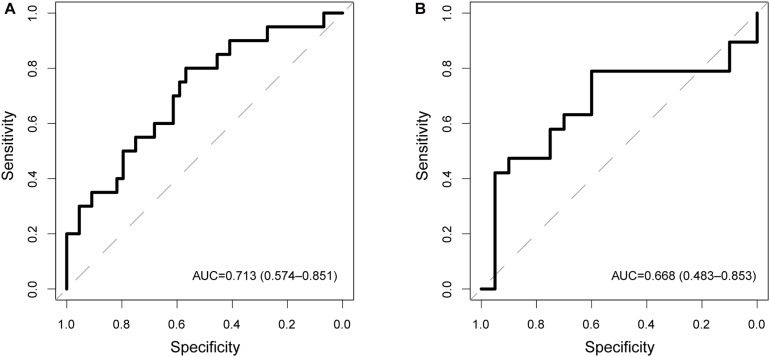
Independent validation in different patient cohorts. Receiver operating characteristic (ROC) curves for the coding-non-coding RNA signature in predicting lymph node metastasis in the testing cohort (A) and GSE26511 cohort (B).